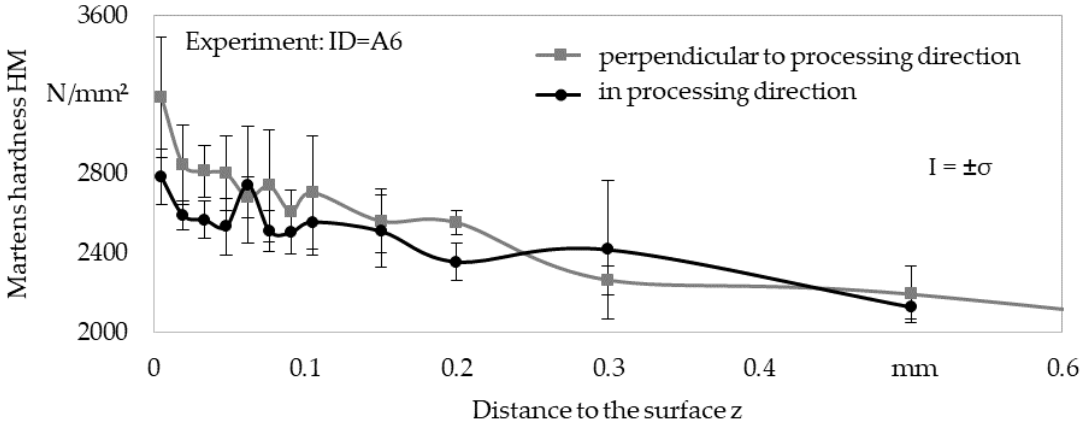
Figure 12. Hardness depth profiles determined utilizing microhardness measurements.